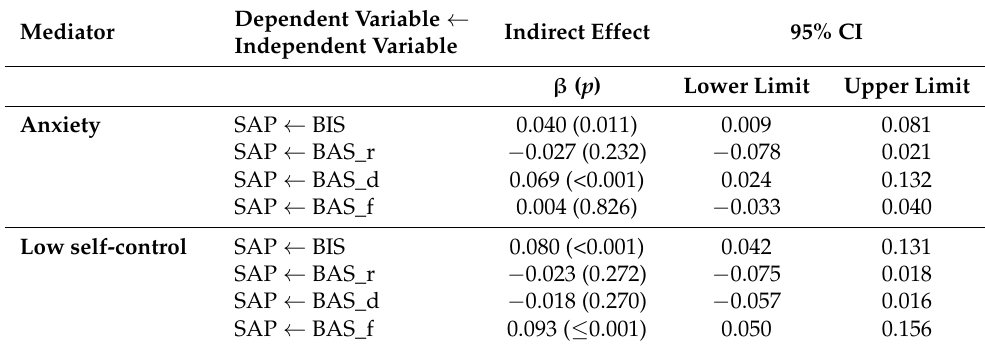
Table 5. Standardized indirect effects of study variables ( n =